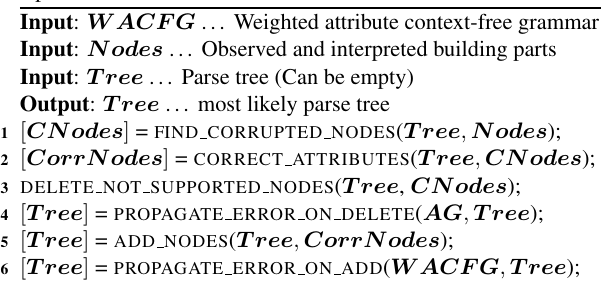
Figure 6: An incremental interpretation of the fac¸ade (Fa) of the Frankenforst manor in Vinxel/ Germany. On the left: Parse tree and the belonging resulted interpretation of two observed floors (Fl) with windows (w) and doors (d). On the right: An updated parse tree after the observation of a further floor. Algorithm 3: TRANSFORM PARSE TREE – Construct or update a parse